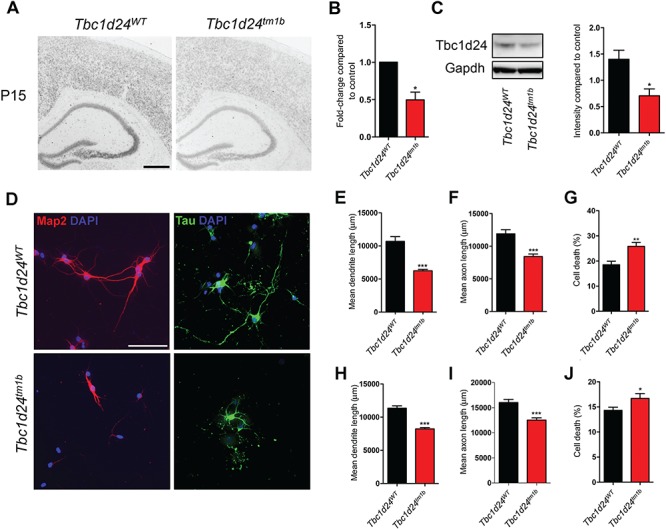
Genetically reduced levels of Tbc1d24 expression alters primary neuronal maturation and survival. (A)In situ hybridization demonstrating a reduction in Tbc1d24 expression in the postnatal (P15) mouse brain from Tbc1d24tm1b mice versus littermate Tbc1d24WT controls. Scale bar: 0.5 mm. A significant reduction in expression in the hippocampus at P15 is confirmed by qRT-PCR (N = 3 animals of each genotype) (B) and western blot (N = 5 animals of each genotype) (C); GAPDH was used as a loading control. (D) Representative immunostaining of primary hippocampal cultures from Tbc1d24WT or Tbc1d24tm1b with dendritic (Map2) and axonal (Tau) markers. Scale bar: 100 µM. (E,F) Quantification of dendrite (E) and axonal (F) length in hippocampal neurons (N > 100 axons/dendrites from 3 independent preparations of each genotype). (G) In the same cultures, the number of apoptotic cells was quantified by cleaved caspase-3 immunostaining after arsenite treatment to induce oxidative stress. (H,I) Quantification of dendrite (H) and axonal (I) length in primary cortical (N > 100 axons/dendrites from 4 independent preparations of each genotype). (J) In the same cultures the number of apoptotic cells was quantified as in (G). Data are expressed as the mean ± SEM. (B, C, E–J) *P < 0.05; **P < 0.05; ***P < 0.001 unpaired t-test compared to Tbc1d24WT.